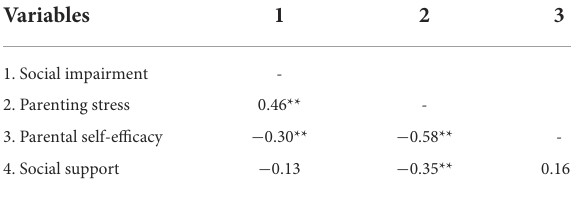
TABLE 3 Summary of correlational coefficients ( N = 185).